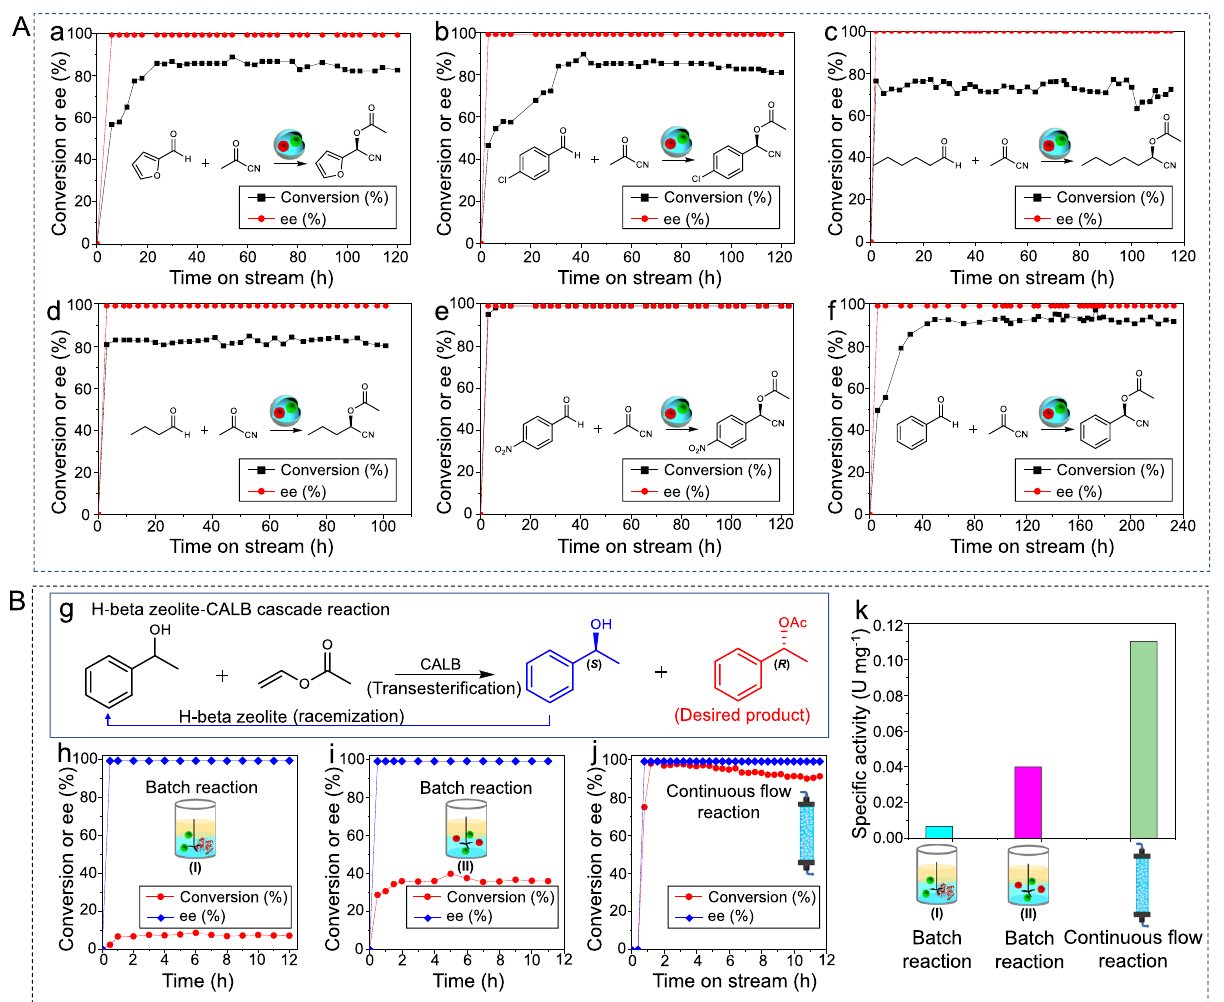
Fig. 6 Substrate scope and cascade reaction extension. A Different substrates for Ti(Salen)-CALB cascade fl ow reactions. The system consists of 0.2 g Ti/SCs, 0.1 g CALB/SCs, 2.1 mL [BMIM]PF 6 , 3 mL PEG-300, and 0.9 mL PBS (pH = 7.4, 0.05 M), 3 mL n -octane, 0.18 g emulsi fi er. Reaction